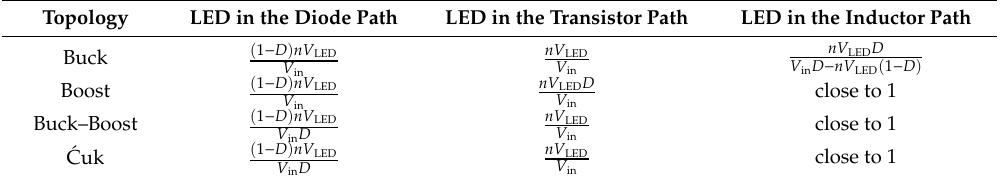
Figure 12. Relationship between efficiency and D of the LED in transistor converter.